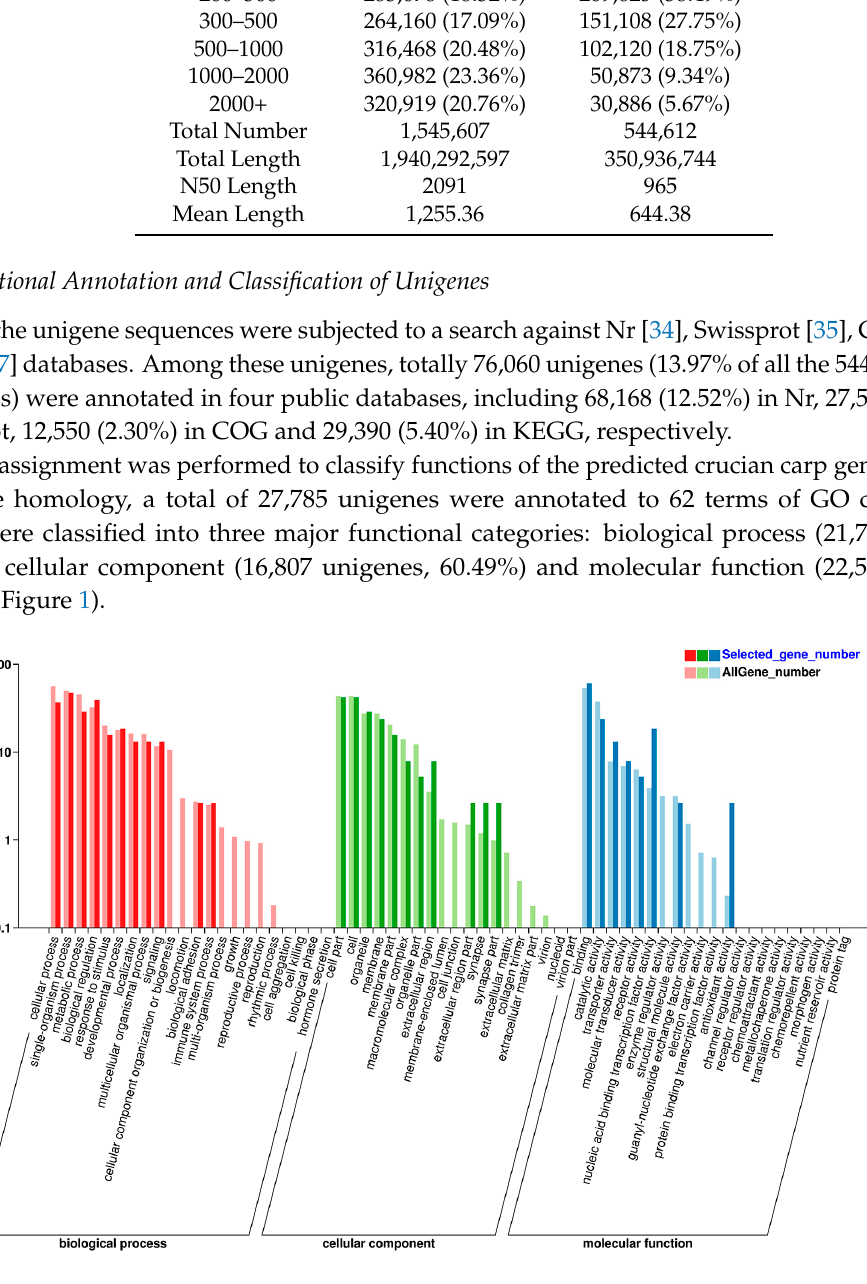
Figure 1. GO classifications of all unigenes and DEGs associating with feed conversion efficiency from brain samples of crucian carp.